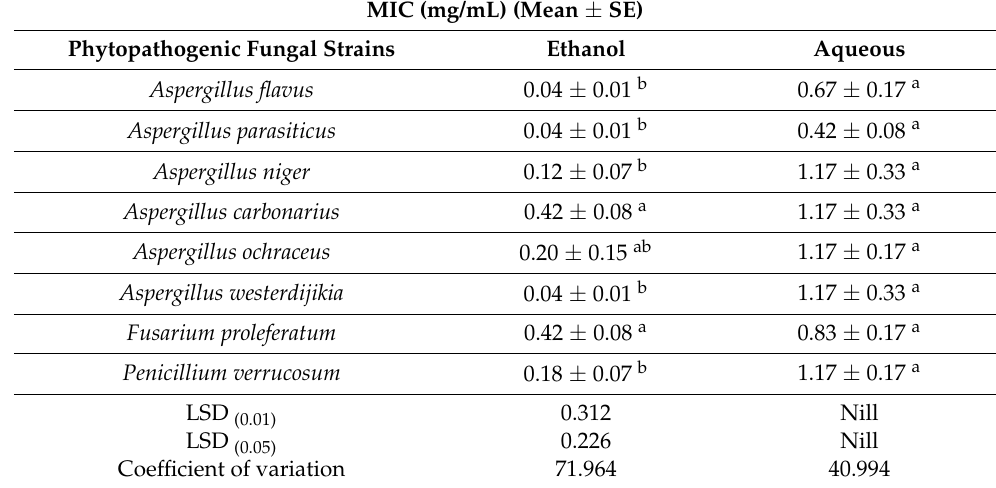
Table 7. The minimum inhibitory concentration of different Moringa extracts against fungal strains. Moringa Ethanolic and Aqueous Extracts and Fungal Strains Phytopathogenic Fungal